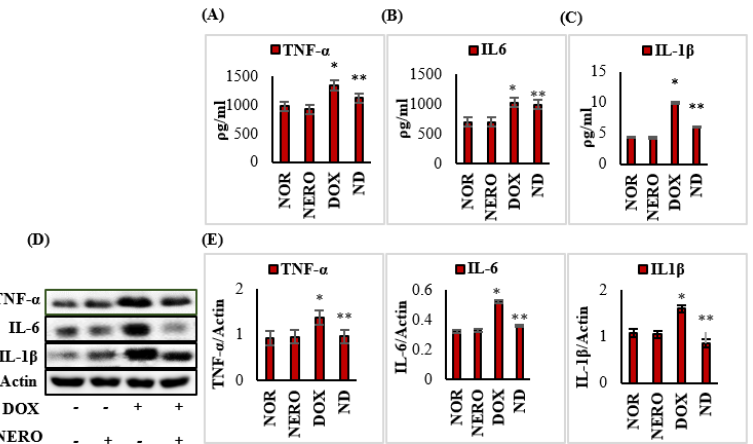
Figure 3. ( A – E ) Levels/expressions of TNF- α , IL-6, and IL-1 β in the myocardium. Each column is mean ± SEM for eight rats in each group for ELISA and 3 rats in each group for immunoblotting. Columns do not share a common symbol (*, **) and differ significantly with each other (* p < 0.05 vs. normal control, ** p < 0.05 vs. DOX control). Representative images of Western immunoblot analysis and densitometric analysis for TNF- α , IL-6, and IL-1 β in the myocardium. TNF- α —tumor necrosis factor α ; IL-6—interleukin 6; IL-1 β —interleukin 1 β ; NOR—normal; NERO—nerolidol; DOX—doxorubicin; ND—rats administered with a single intraperitoneal dose of DOX and orally treated with NERO.